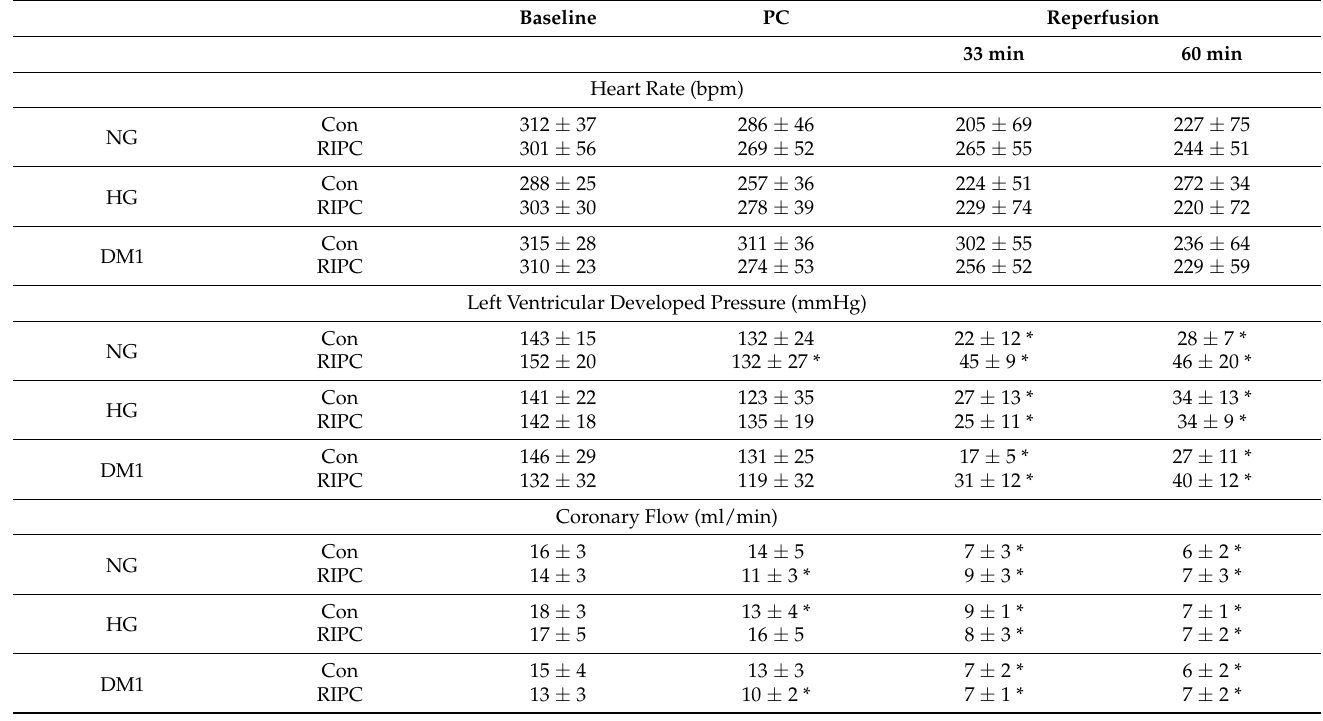
Table 2. Hemodynamic variables from part 1 (plasma transfer diseased → healthy).